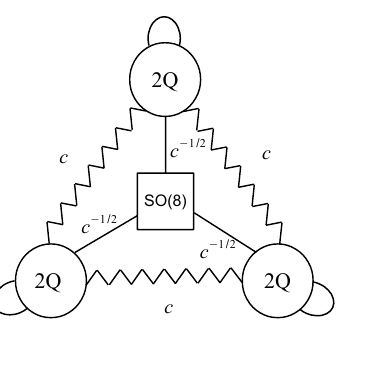
(cid:0) 3 (cid:1) , 3 , 3 , 3 , 3 , 3 , 3 , 3 2 2 2 2 2 2 2 2